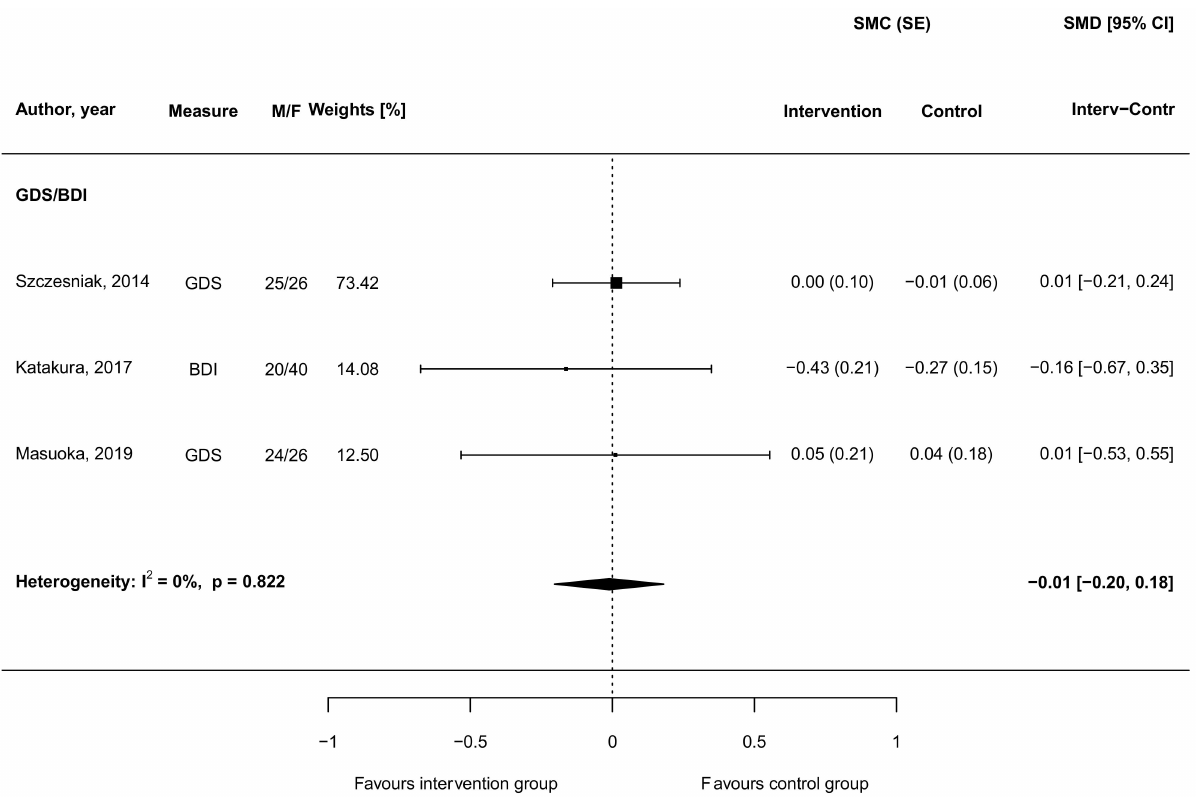
Figure 5. Standardized mean differences in depressive symptoms outputs between intervention groups supplemented with carnosine and control groups in randomized controlled trials. Abbreviations: BDI (Beck Depression Inventory), CI (confidence interval), F (female), GDS (Geriatric Depression Scale), M (male), SE (standard error), SMC (standardized mean change), SMD (standardized mean